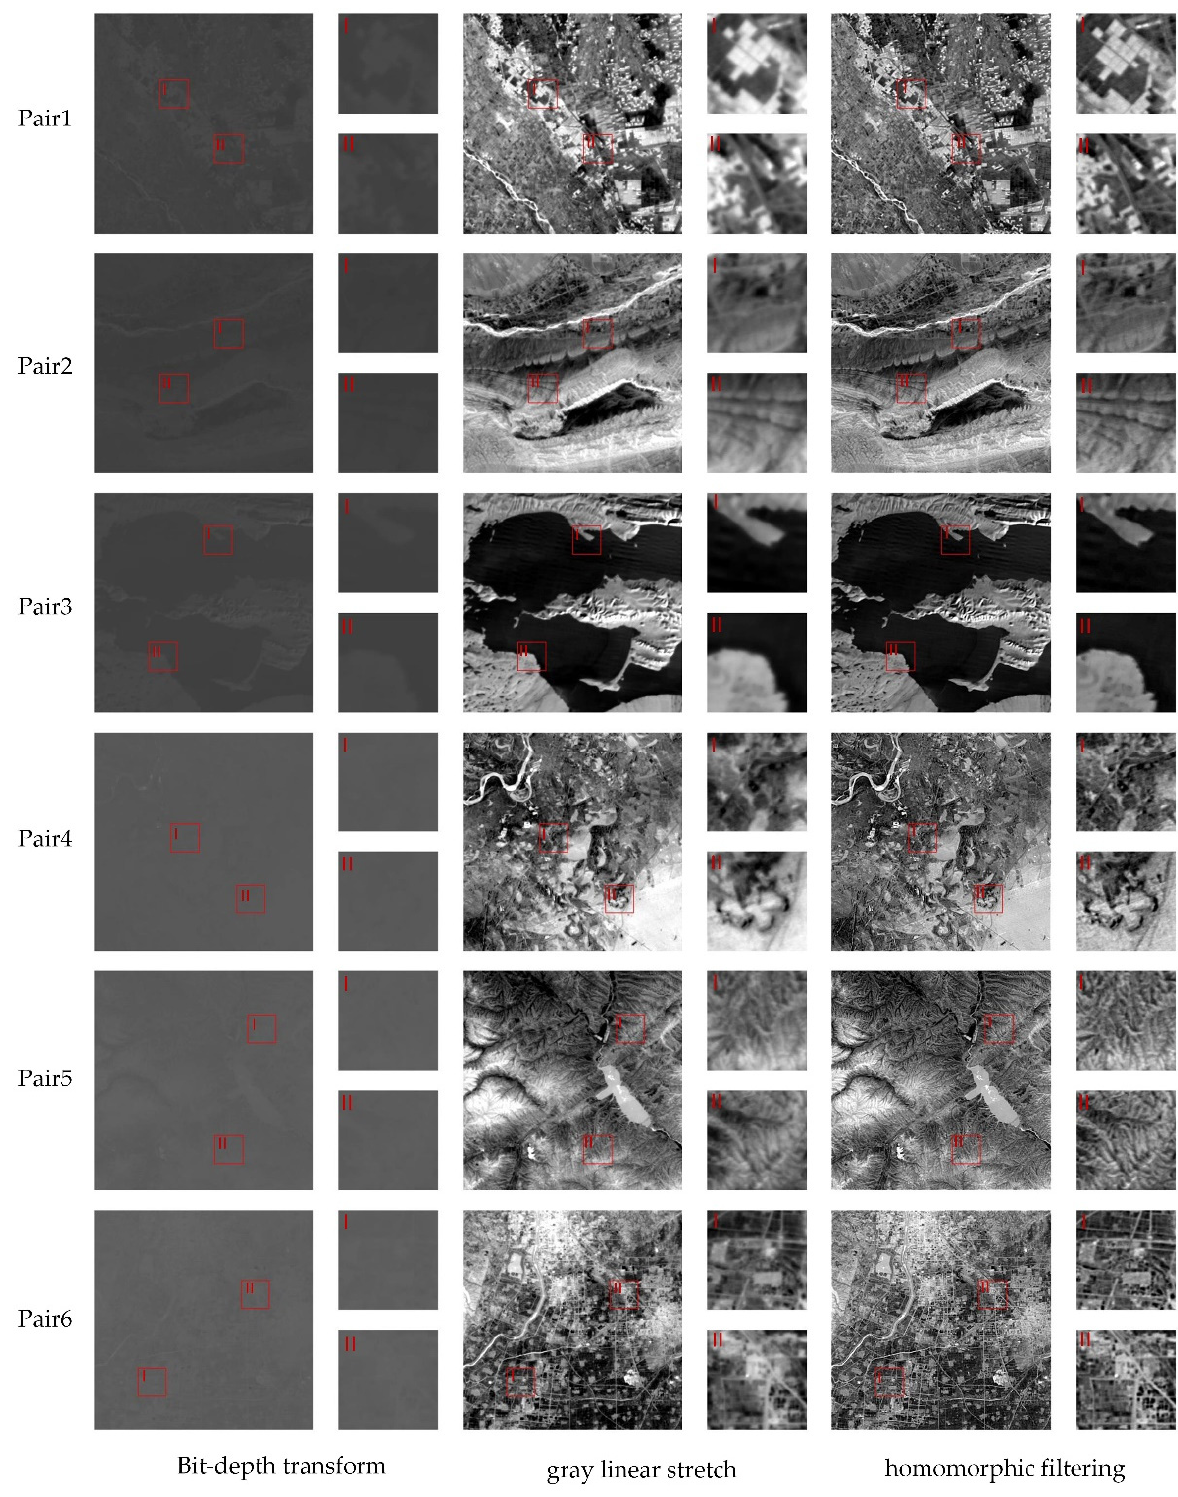
Figure 9. The gray transformation from 12-bit to 8-bit by using bit-depth transform, gray linear stretch and homomorphic filtering respectively.